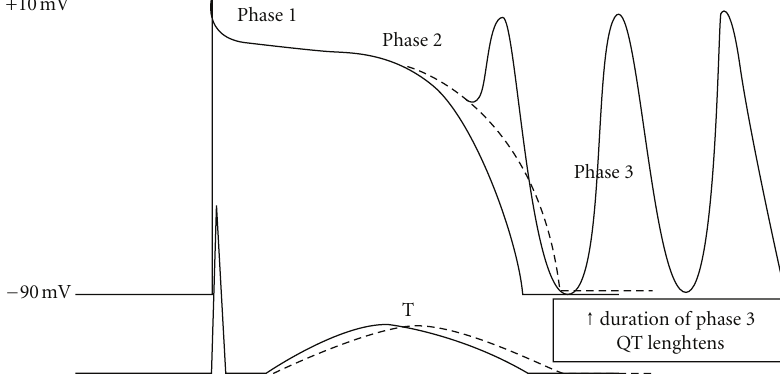
Figure 3: Multiple early afterdepolarizations (EADs) from progressively more negative transmembrane potential.